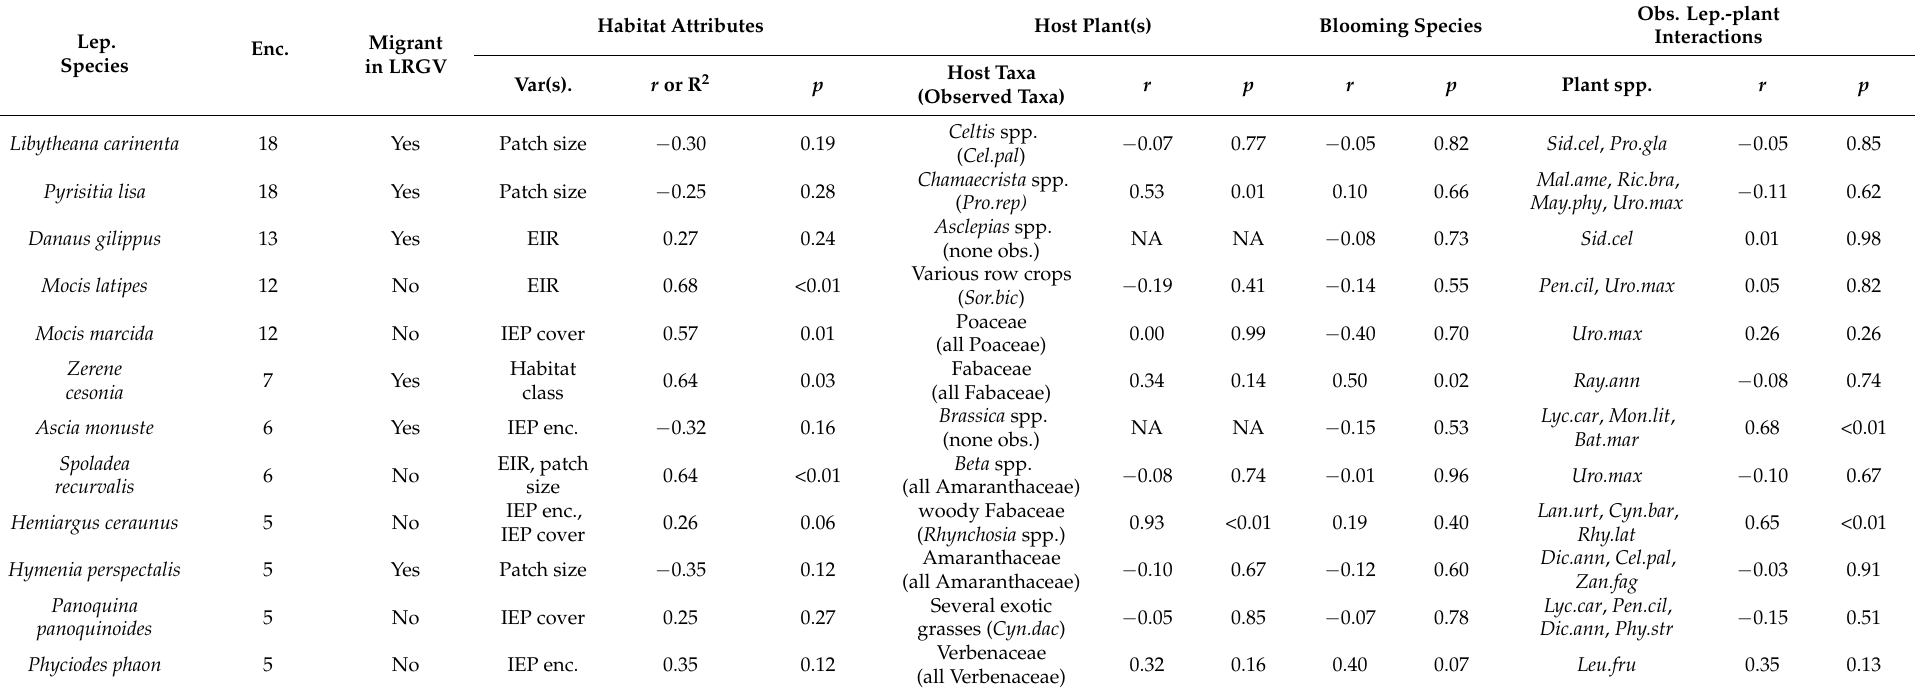
Table 9. List of the 12 most commonly encountered Lepidoptera species observed in this study, with the total number of encounters and migratory status in the LRGV for each. Also shown for each Lepidoptera species are the relationships between the abundance of that species at each study site and (a) key habitat attributes, (b) the abundance of potential host plants, (c) the abundance of plant species in bloom during surveys (i.e., likely nectar sources), and (d) the abundance of plant species with which the Lepidoptera species was observed to be interacting during surveys. All abundance values were normalized based on sampling effort. Each relationship is summarized by its Pearson correlation coefficient ( r ) and its linear model p -value ( p ); or by the coefficient of determination (R 2 ) instead of r where habitat class or multiple environmental variables had a significant relationship with Lepidoptera species abundance. For habitat attributes, the same six core environmental variables were considered as previously, namely habitat class, patch size, edge to interior ratio (EIR), IEP plant cover, IEP plant encounter rate, and ln (Native: IEP encounters). For host plants, known host taxa are named, and then relevant taxa within or related to that group that were observed in this study are denoted in parentheses. Blooming species include the same set of plants as for the blooming plant cover and encounter rate variables considered previously. For observed Lepidoptera-plant interactions, specific plant species that the Lepidoptera taxa was observed feeding from, foraging on, perched upon, or otherwise interacting with are listed. Relationships with invasive grass abundance were also considered, but none were significant, and they are not shown. Full species names and taxonomic information corresponding to the species codes shown here are found in Tables S1 and S2 (the full species